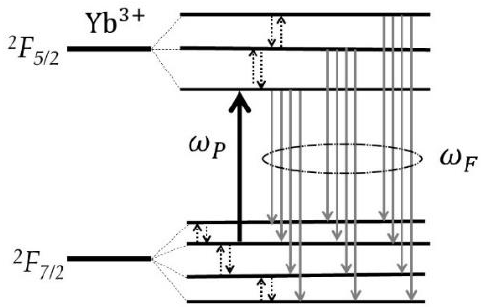
Figure 2. Energy levels of Yb 3+ ions doped in a solid. Arrows illustrate the excitation and decay processes for a cooling cycle.